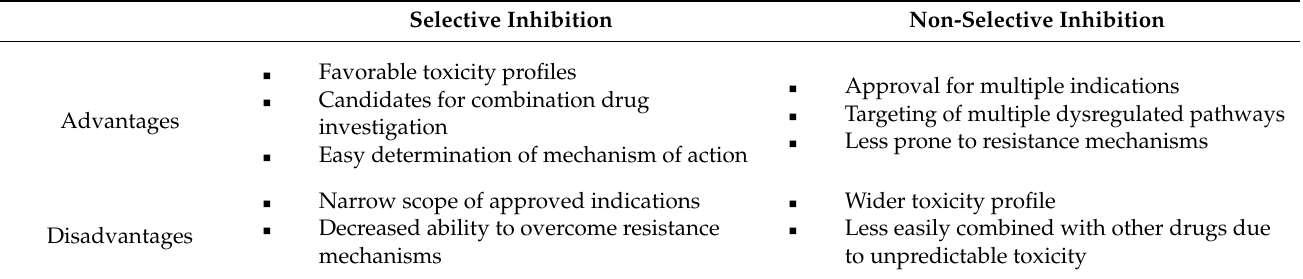
Table 4. Advantages and disadvantages of selective vs. nonselective inhibitors.